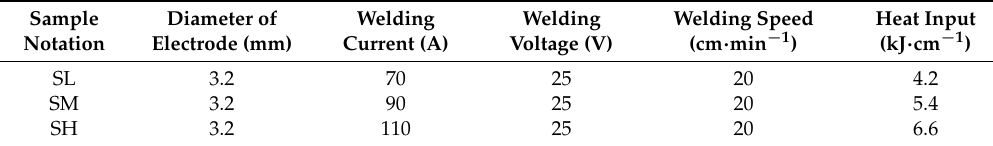
Table 2. Welding parameters for the repair process of 5Cr5MoV die